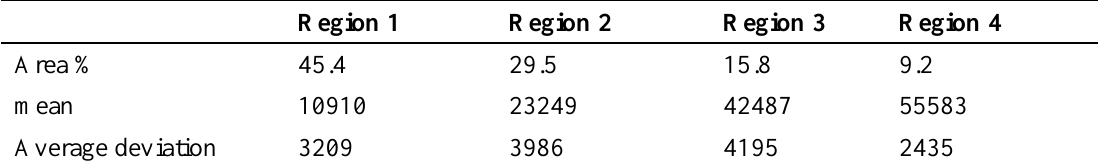
Figure 4. Zoning of wind power with 15 m rotor radius The wind power potential increases up to 68350 𝑤. 𝑚 −2 when using turbines with 25 m rotor radius in the eastern regions of province (Table 5 and Figure 5). Although increasing rotor radius increases wind power, the extent of the area with maximum wind power decreases compared to the previous cases. Therefore, the area of region 4 decreases in favor of region 1. Table 5. The statistical characteristics of wind power with 25 m rotor radius